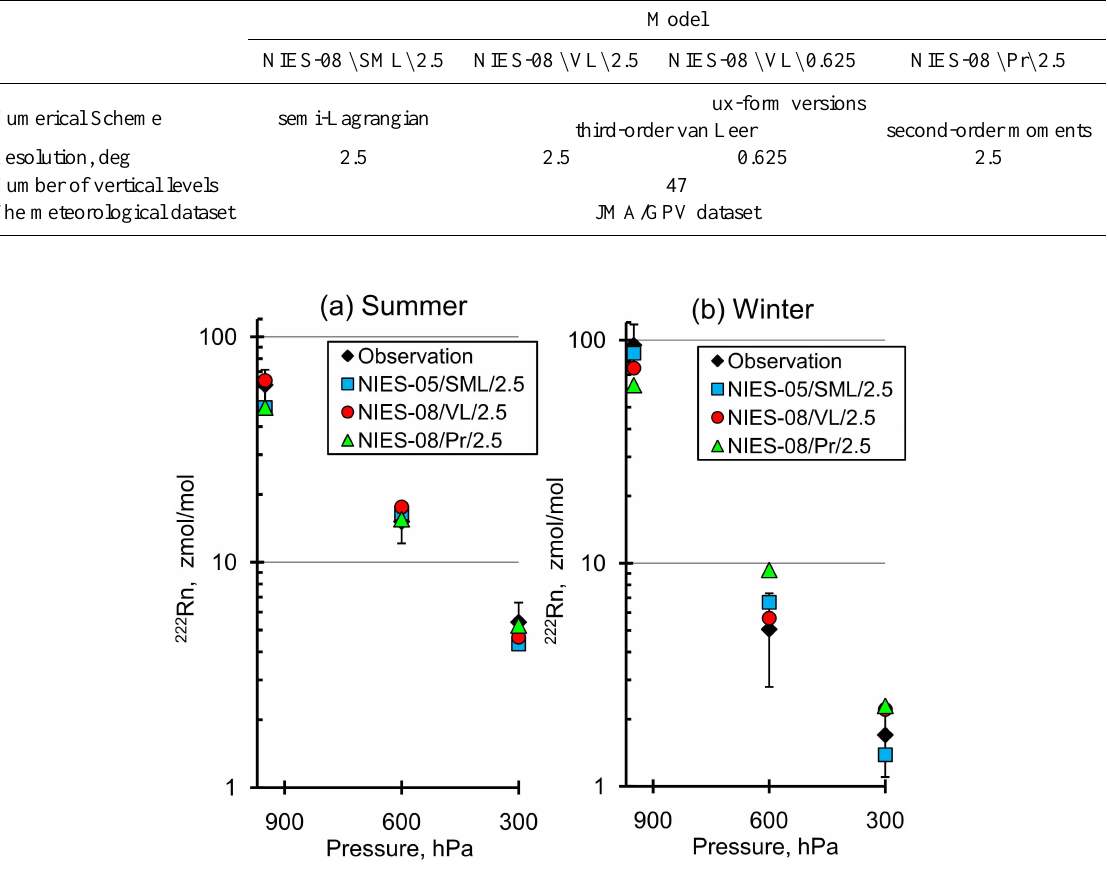
Fig. 3. Comparisons between observations and model simulations of 222 Rn averaged concentration over three northern midlatitude continen- tal sites during summer and winter seasons. Results at three vertical levels (mixing layer, 600hPa and 300hPa) are shown. The observation data was obtained by aircraft measurements made at Cincinnati (40 ◦ N, 84 ◦ W), Socorro (34 ◦ N, 107 ◦ W), and Kirov (58 ◦ N, 49 ◦ E) with the corresponding standard